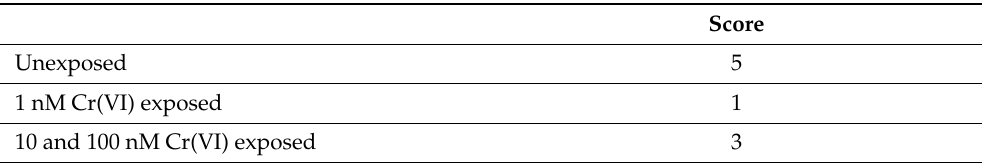
Table 2. Mean values of sperm motility, evaluated according to a sperm motility score. Measurements were made on sperm suspensions from M. galloprovincialis unexposed and exposed to 1, 10, and 100 nM chromium (VI).